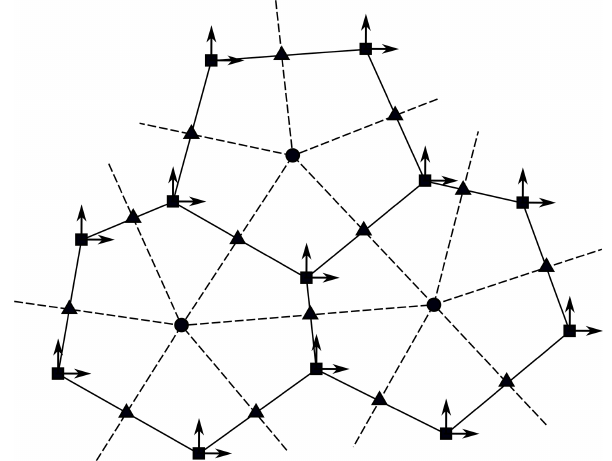
Figure 1. Schematic representation of three cells in an example MPAS mesh. The mesh is composed of cell centers (circles), cell edge points (triangles), and cell vertices (squares). The dual trian- gular Delaunay mesh is formed by joining cell centers (dashed line). MPAS-Seaice uses a “B” type grid, with both velocity components defined at cell vertices. Unlike traditional quadrilateral meshes, the directions of the velocity components in MPAS-Seaice are not in general aligned with the cell